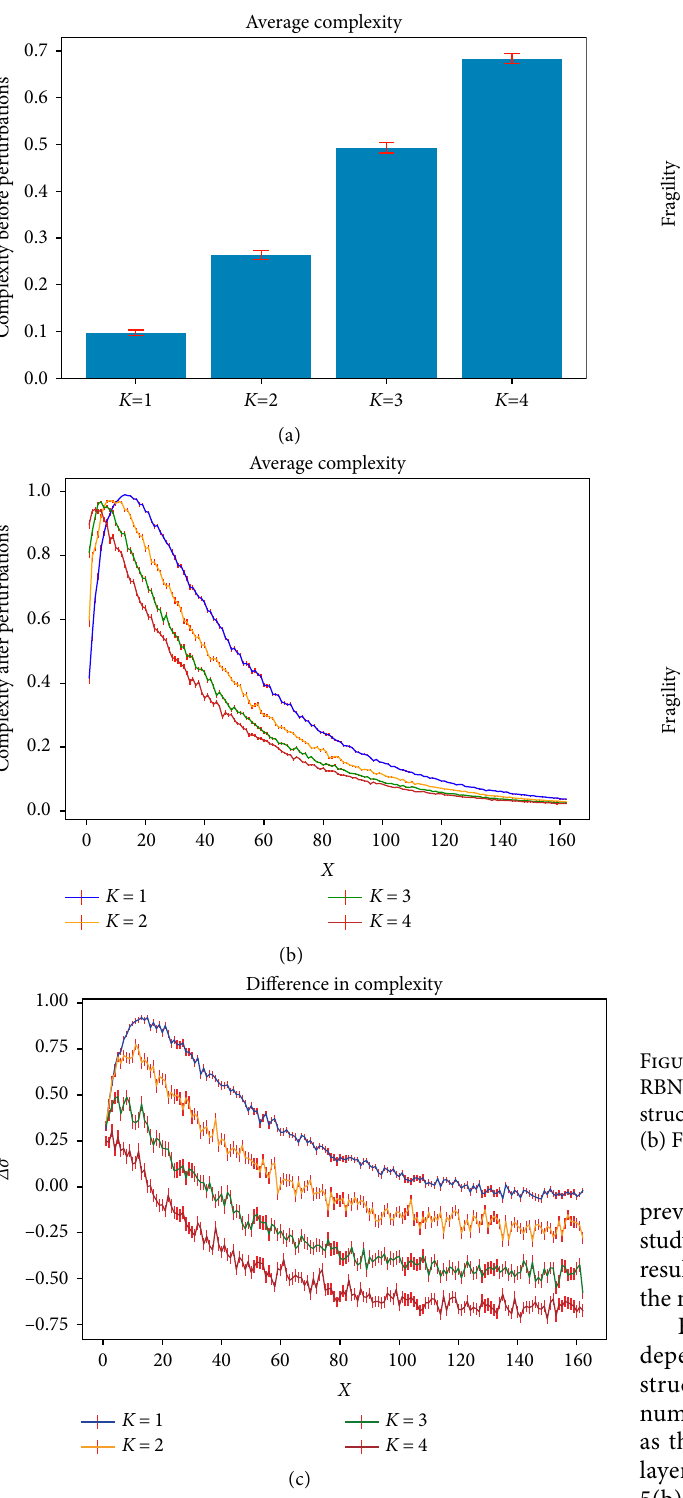
Figure 4: Average complexity of ordered, critical, and chaotic multilayer RBNs. (a) Complexity before perturbations. (b) Complexity after perturbations. (c) Difference of complexity before and after perturbations.